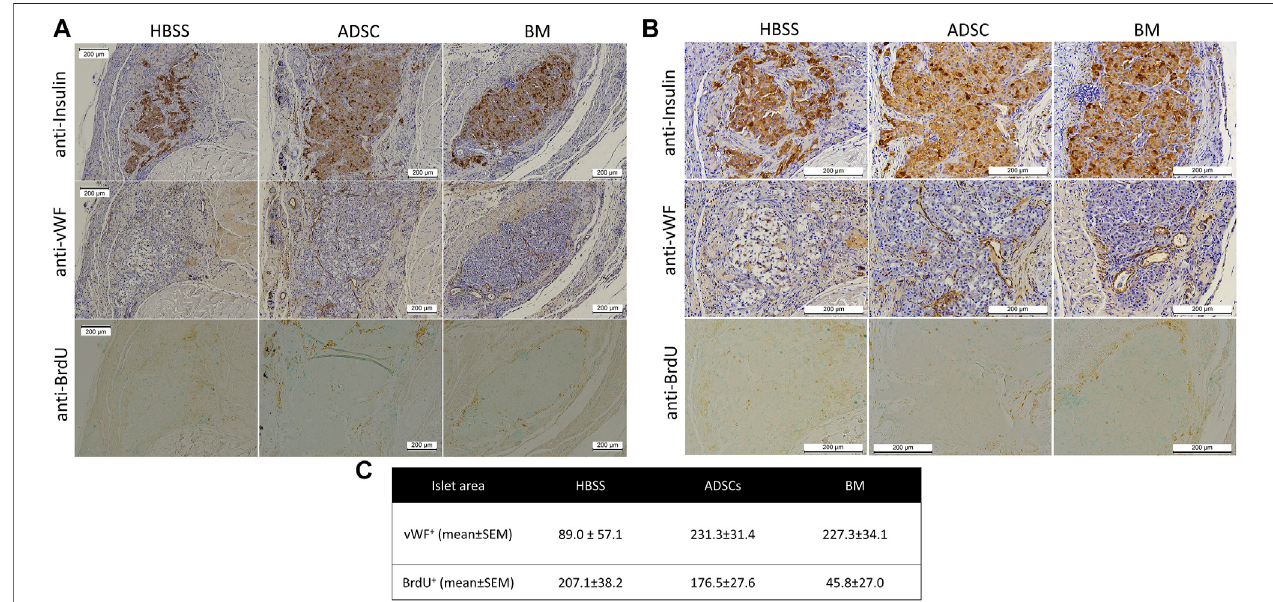
FIGURE 9 | Representative images of the immunohistochemical staining of the scaffold showing anti-insulin (upper panel), anti-Von-Willebrand factor (middle panel), and anti-BrdU (lower panel) staining of the islet region [ (A) low magni fi cation (100x) and (B) high magni fi cation (200x)]. (C) There were more vWF + cells in the isletregionintheADSCandBMgroupsthanintheHBSSgroup,whilethenumbersofBrDU+cellsweresigni fi cantlylowerintheBMgroupthanintheothertwogroups.